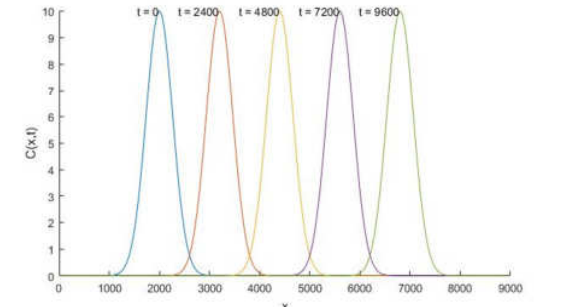
Figure 1. Propagation of initial pulse with constant wave